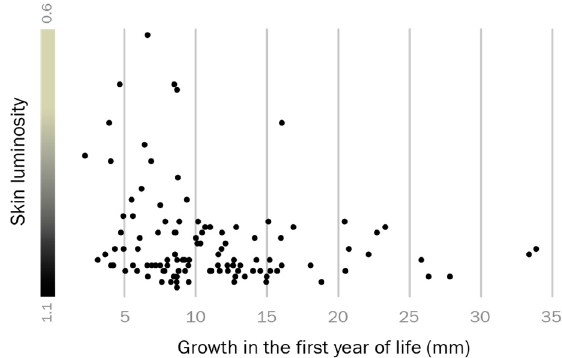
Figure 3. Predetermination of the territorial phenotype. Males that grew better than average in their first year of life (dots towards the right side of the graph) often display a black-colored territorial phenotype in the spawning season.